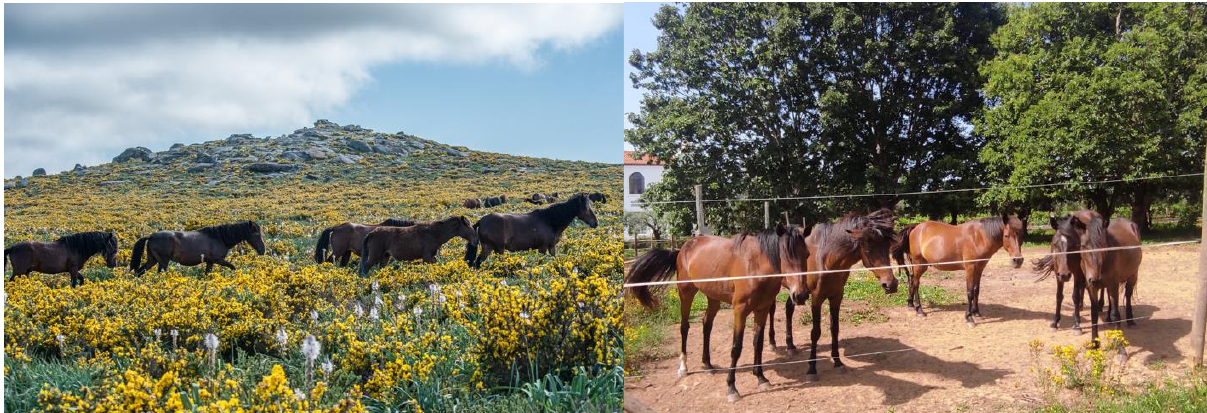
Figure 1. ( Left ): Garrano horses in the wild in Serra d'Arga. The feral horses live in a family group called the one-male unit (OMU), consisting of one adult male and multiple females and their dependents. ( Right ): A group of five captive participant horses simulating a natural family group (OMU). Their enclosure is located within walking distance (about 9 km) of their natural habitat, in Lanheses, Viana do Castelo. (Photos by Barbara Ryckewaert).